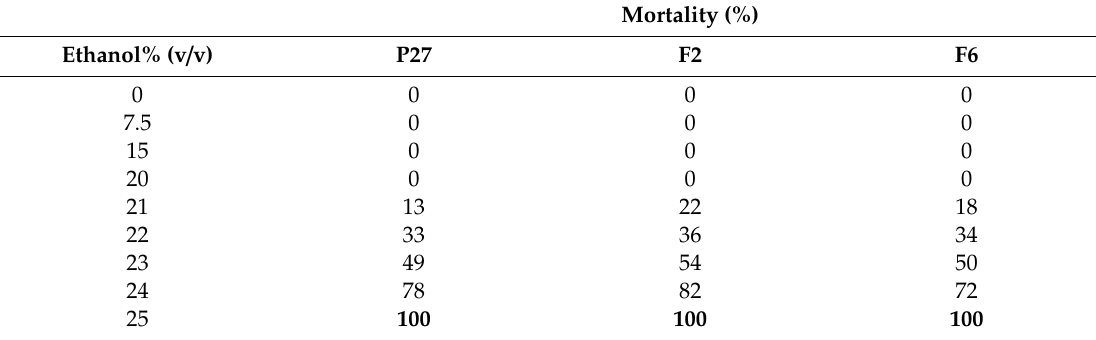
Table 1. Mortality (%) induced by increasing ethanol concentrations on 27P, F2 and F6 strains.